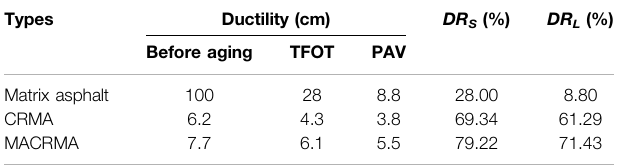
TABLE 4 | Softening point test results of three kinds of asphalts at different aging stages. Types